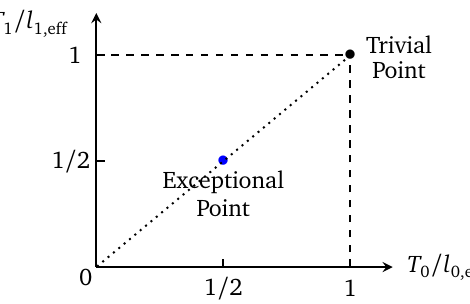
Figure 3: Phase diagram of a randomly driven CFT with two arbitrarily chosen non-commuting elliptic Hamiltonians H and H . The phase diagram is periodic 0 1 / l / l in T and T . The randomly driven CFT is in the heating phase ev- 0 0,eff 1 1,eff / l / l < 1 except at the exceptional point erywhere in 0 < T , T 0 0,eff 1 1,eff